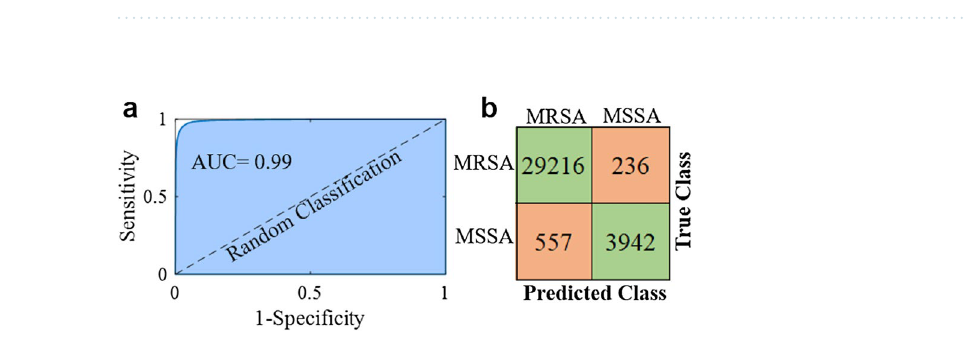
Table 1. Mean accuracies of the classifiers with maximum, minimum and standard deviation for 30 runs.